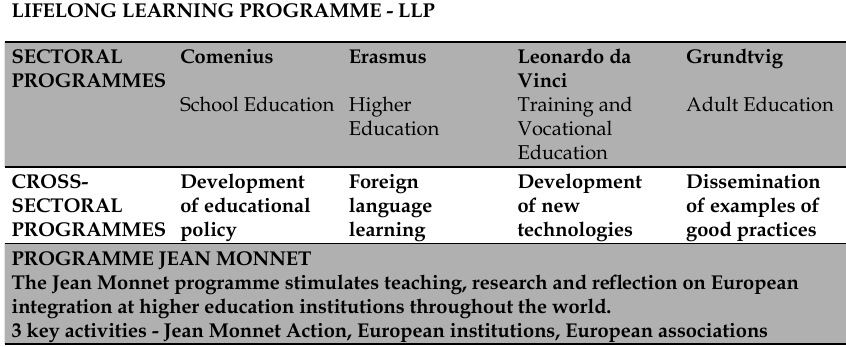
Table 1. Structure of the programme Lifelong Learning